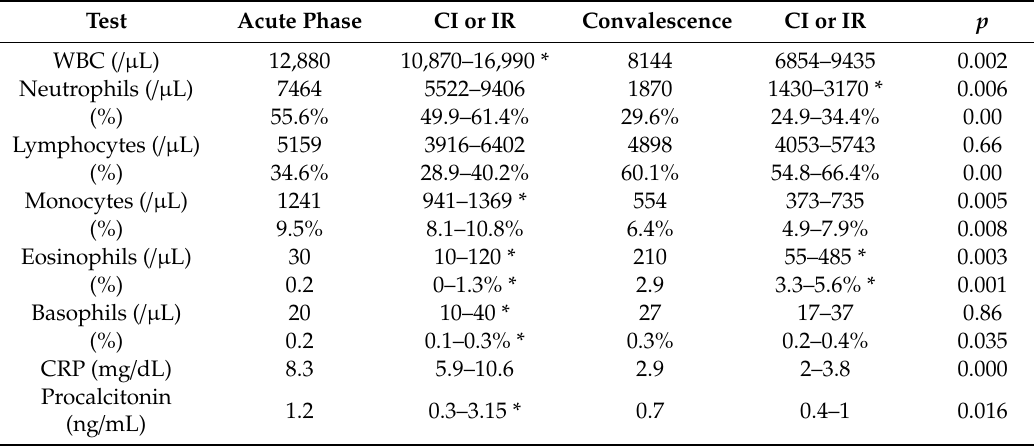
Table 3. White blood cell (WBC) count, C-reactive protein (CRP), and Procalcitonin levels in 23 patients a ff ected by Adenoviral AURTIs during the febrile (acute) and afebrile (convalescence) phases, p values reflect di ff erence in means.